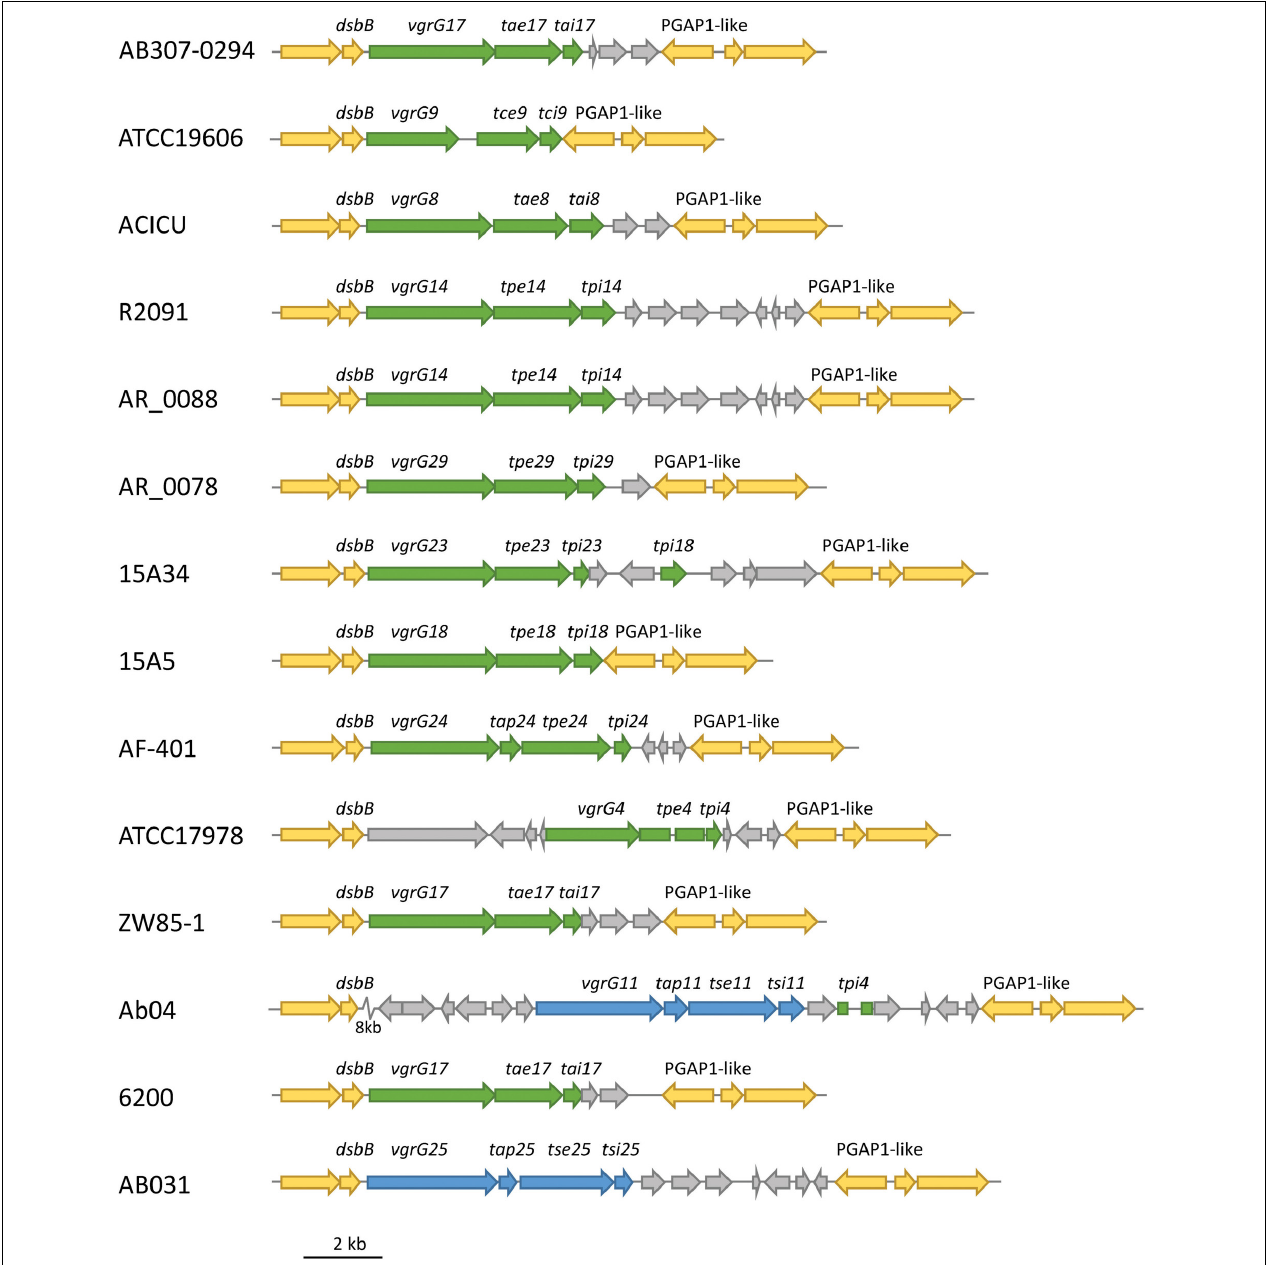
FIGURE 10 | Conserved genomic position of effector loci encoding a Type 1 VgrG protein. The genomic positions of effector loci encoding Type 1 VgrG proteins were identified in 14 A. baumannii strains and shown to be present between conserved dsbB (upstream) and PGAP1-like (downstream) genes. These loci are predicted to encode peptidoglycan hydrolase effectors (green) and two effectors with no predicted function (blue). Genes conserved across all strains are shown in yellow. Gray genes are additional genes that were not conserved across all strains. Rectangles represent truncated genes. An 8-kbp section of Ab04 (zig zag symbol) was condensed for clarity and contained only non-conserved